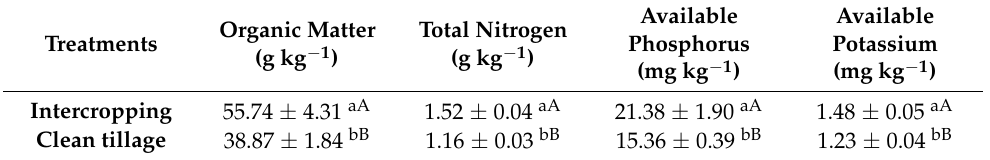
Table 2. Effects of intercropping V. sativa on soil nutrient of young kiwifruit orchard.